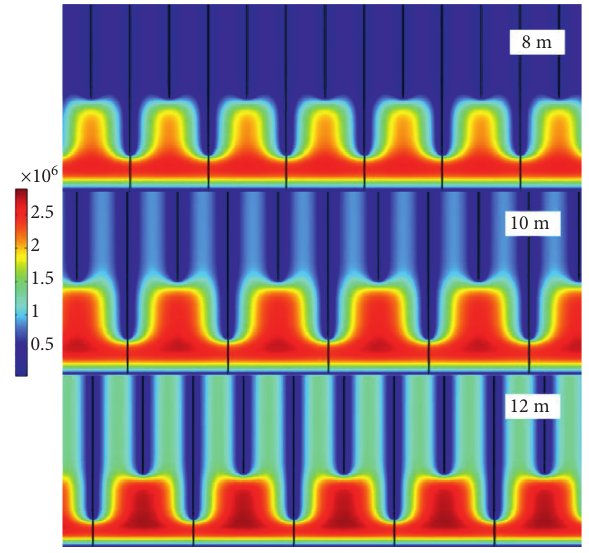
Figure 8: Gas pressure distribution at different spacing of boreholes.